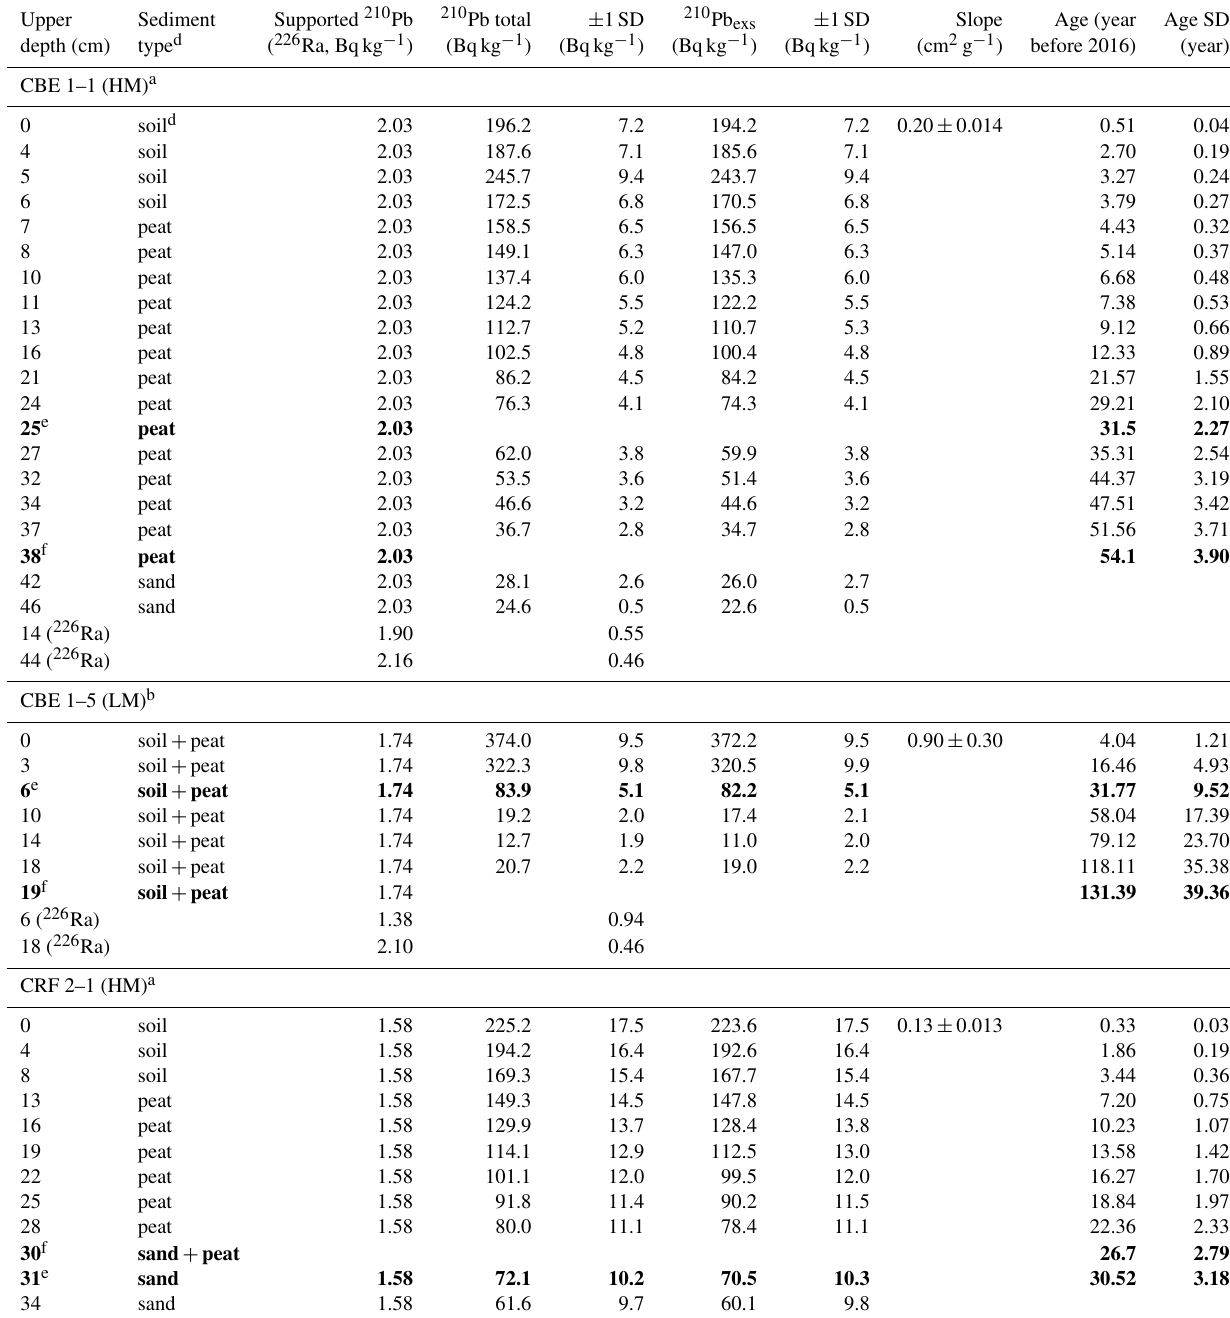
Table A2. Downcore distribution of 210 Pb and 226 Ra in eight cores used for 210 Pb dating.